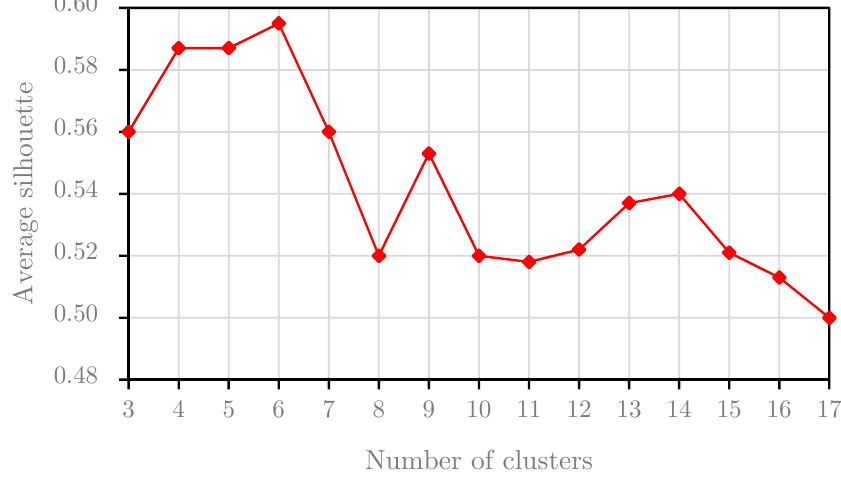
Figure 8. The average silhouette score per number of clusters for the B2 dataset.